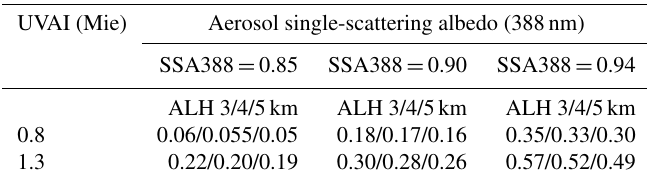
Table 2. Theoretical simulations of the retrieved ACAOD for two discrete values of UVAI under different combinations of SSA and ALH assumptions. Threshold values of 0.8 and 1.3 in UVAI correspond to the algorithm quality flags of “0” (best) and “2” (less